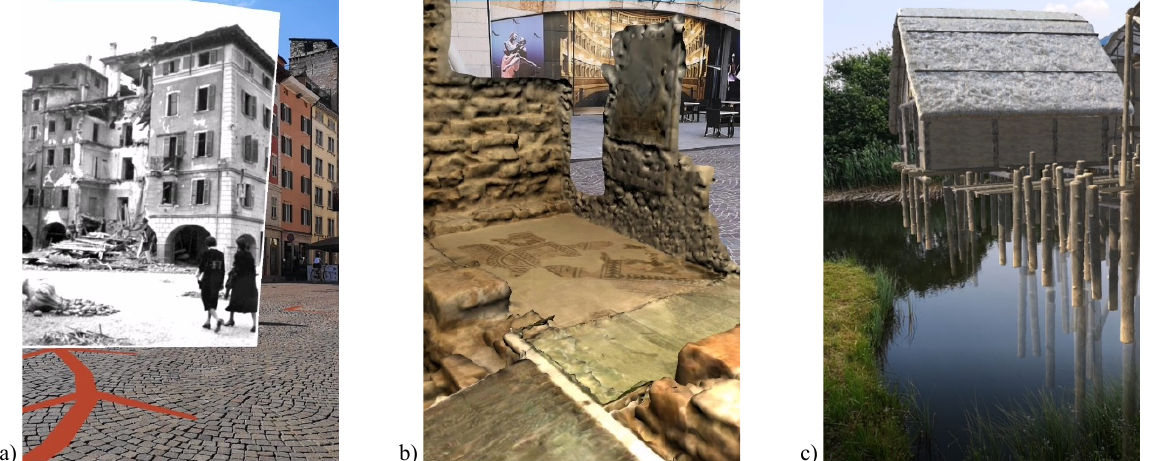
Figure 1 . The three large-scale scenarios used in the paper and the AR results based on markerless smartphone solution: (a) historical photographs of the city of Trento, (b) the remains of the underground roman city in Trento and (c) the pile dwelling site of